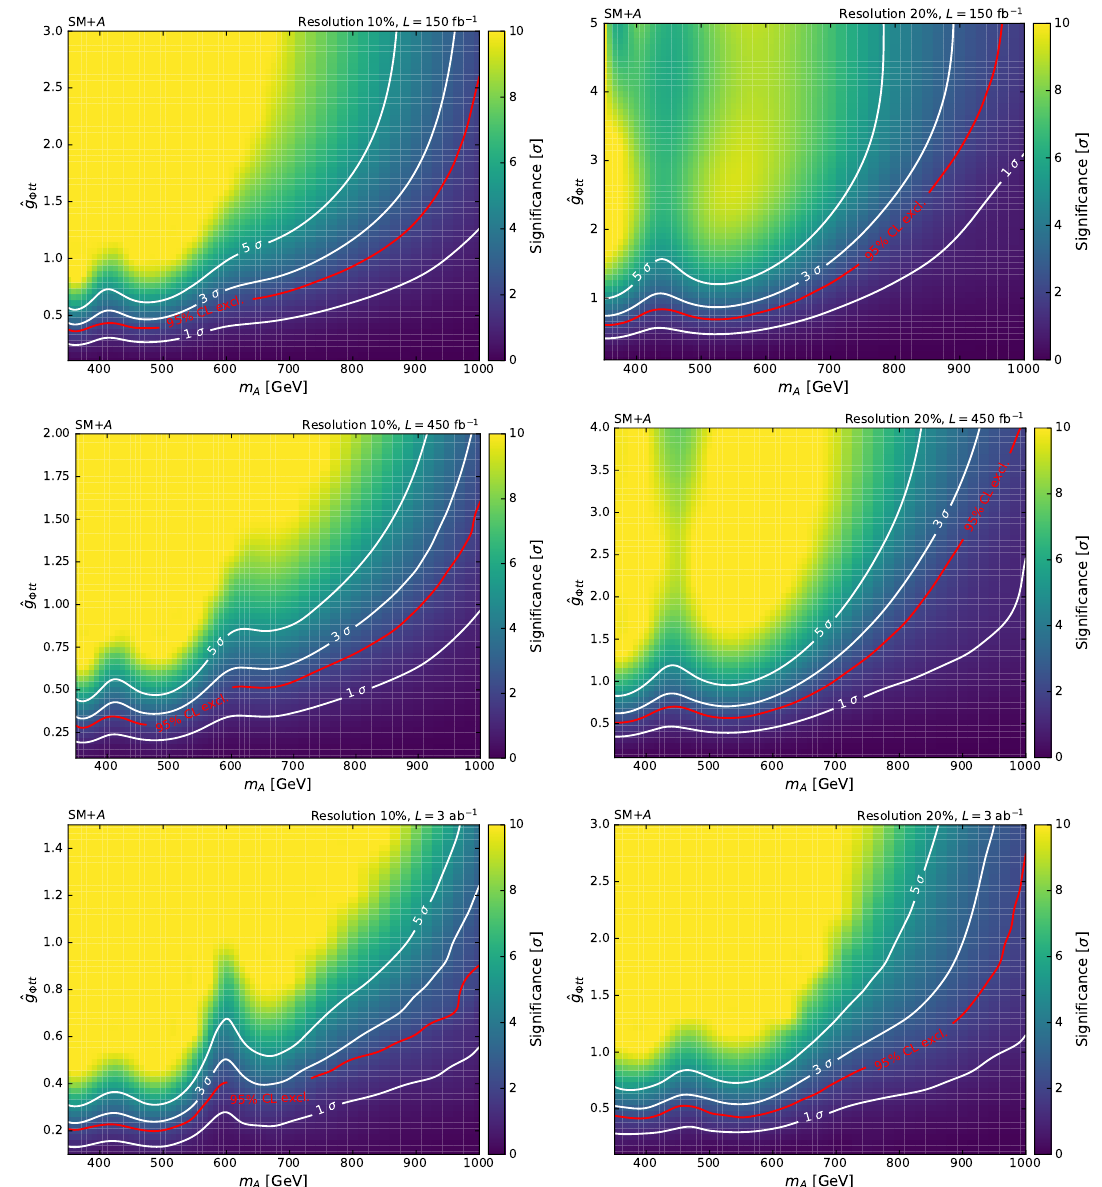
Figure 9 . Expected signi(cid:12)cance and exclusion potential for the SM+ A model in the six experimen- tal scenarios considered, as described in the legends and in the text: 10 (20)% mass resolution in the left (right) panels and 150 (450) (3000)/fb of integrated luminosity in the top (middle) (bottom) row of panels, as indicated in the legend. Values of signi(cid:12)cance in excess of 10 (cid:27) are